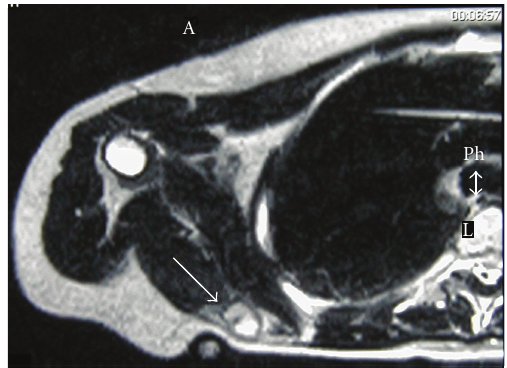
Figure 2: MRI of the right scapula showing a decrease in size of the PEComa after completion of neoadjuvant treatment (arrow). Edema of the surrounding infraspinatus muscle is evident as a bright area with less distinct boundaries than the